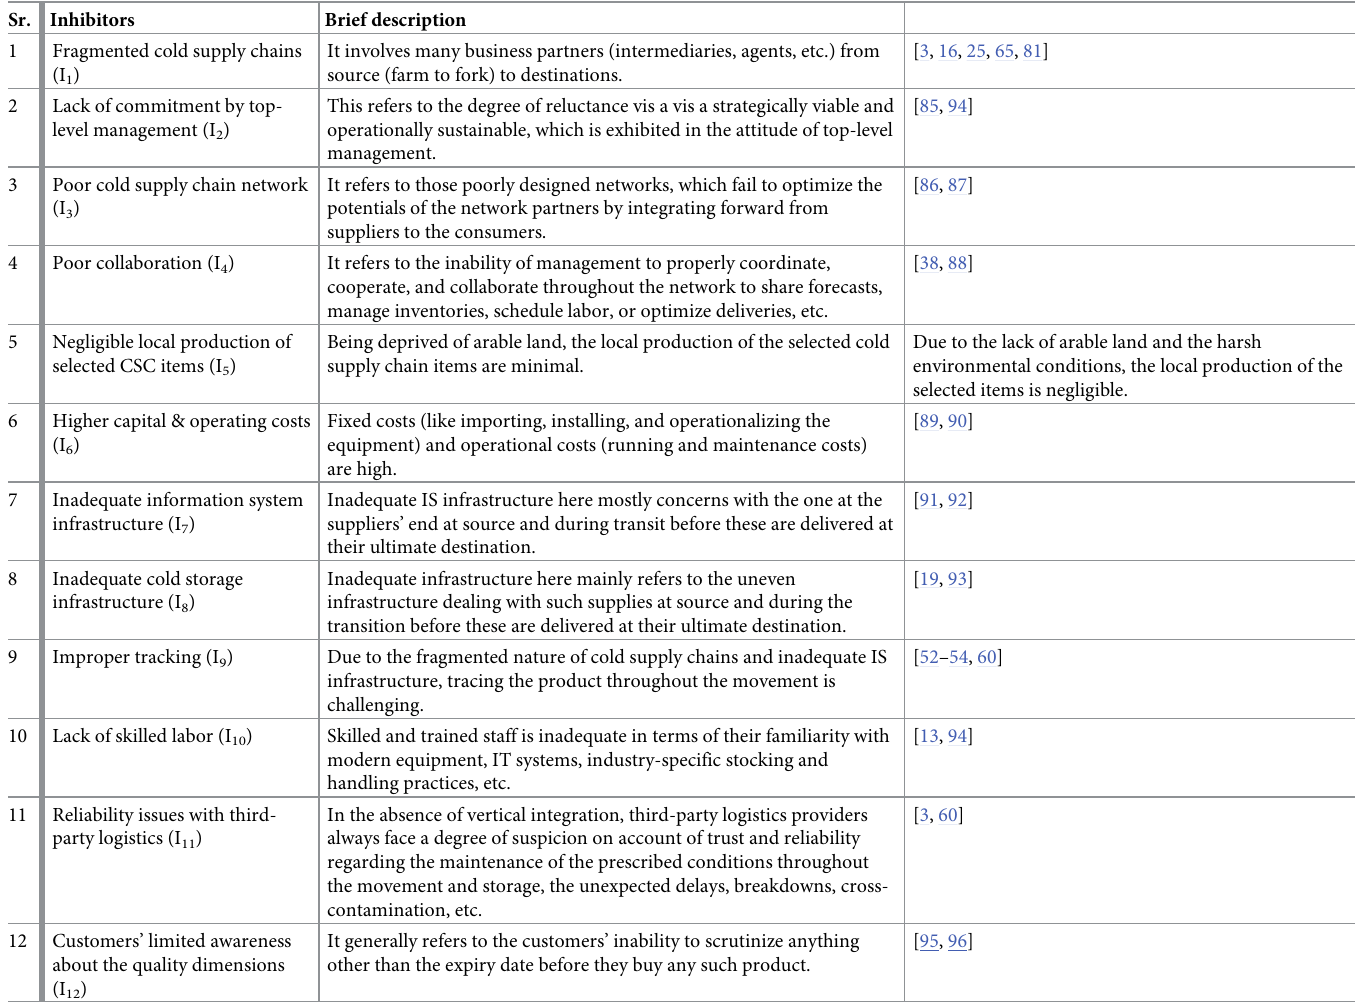
Table 1. Selected inhibitors for the current study.